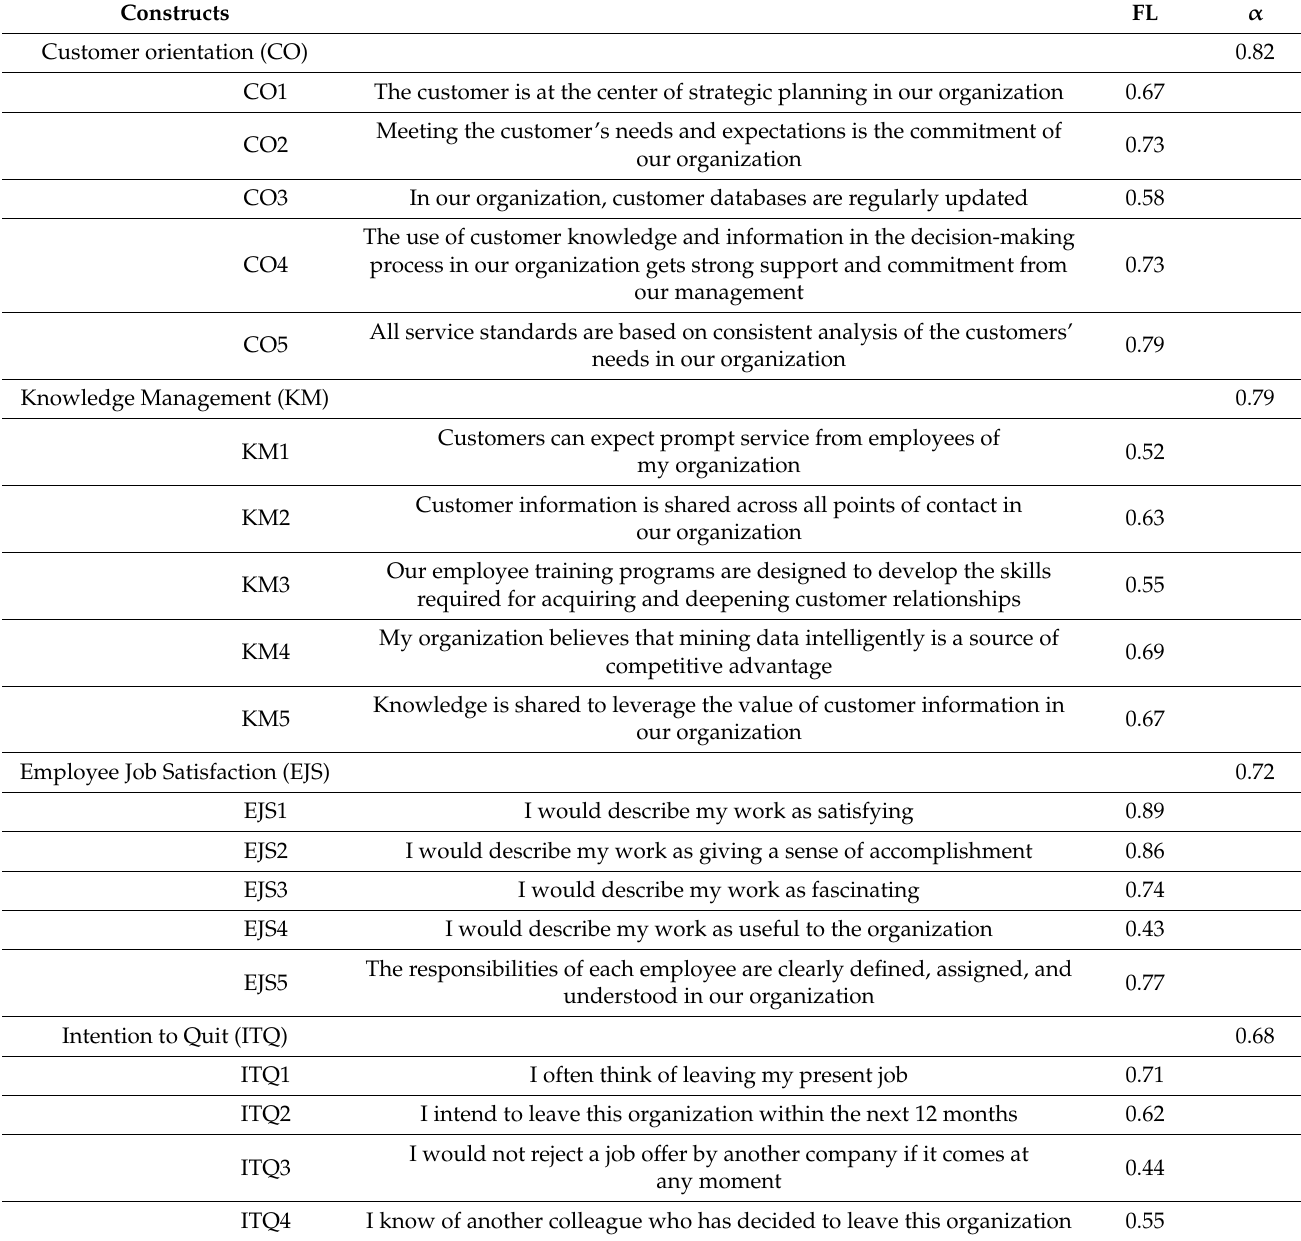
Table 1. Results of validity and reliability